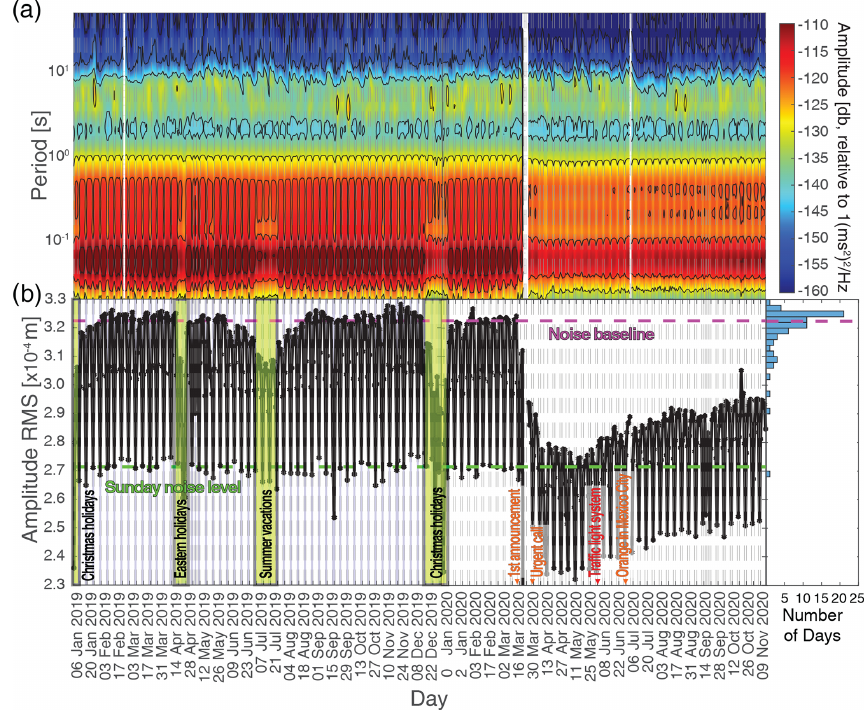
Figure 3. (a) Daily median power spectral density for station PZIG. (b) Daily rms noise level for frequencies between 1 and